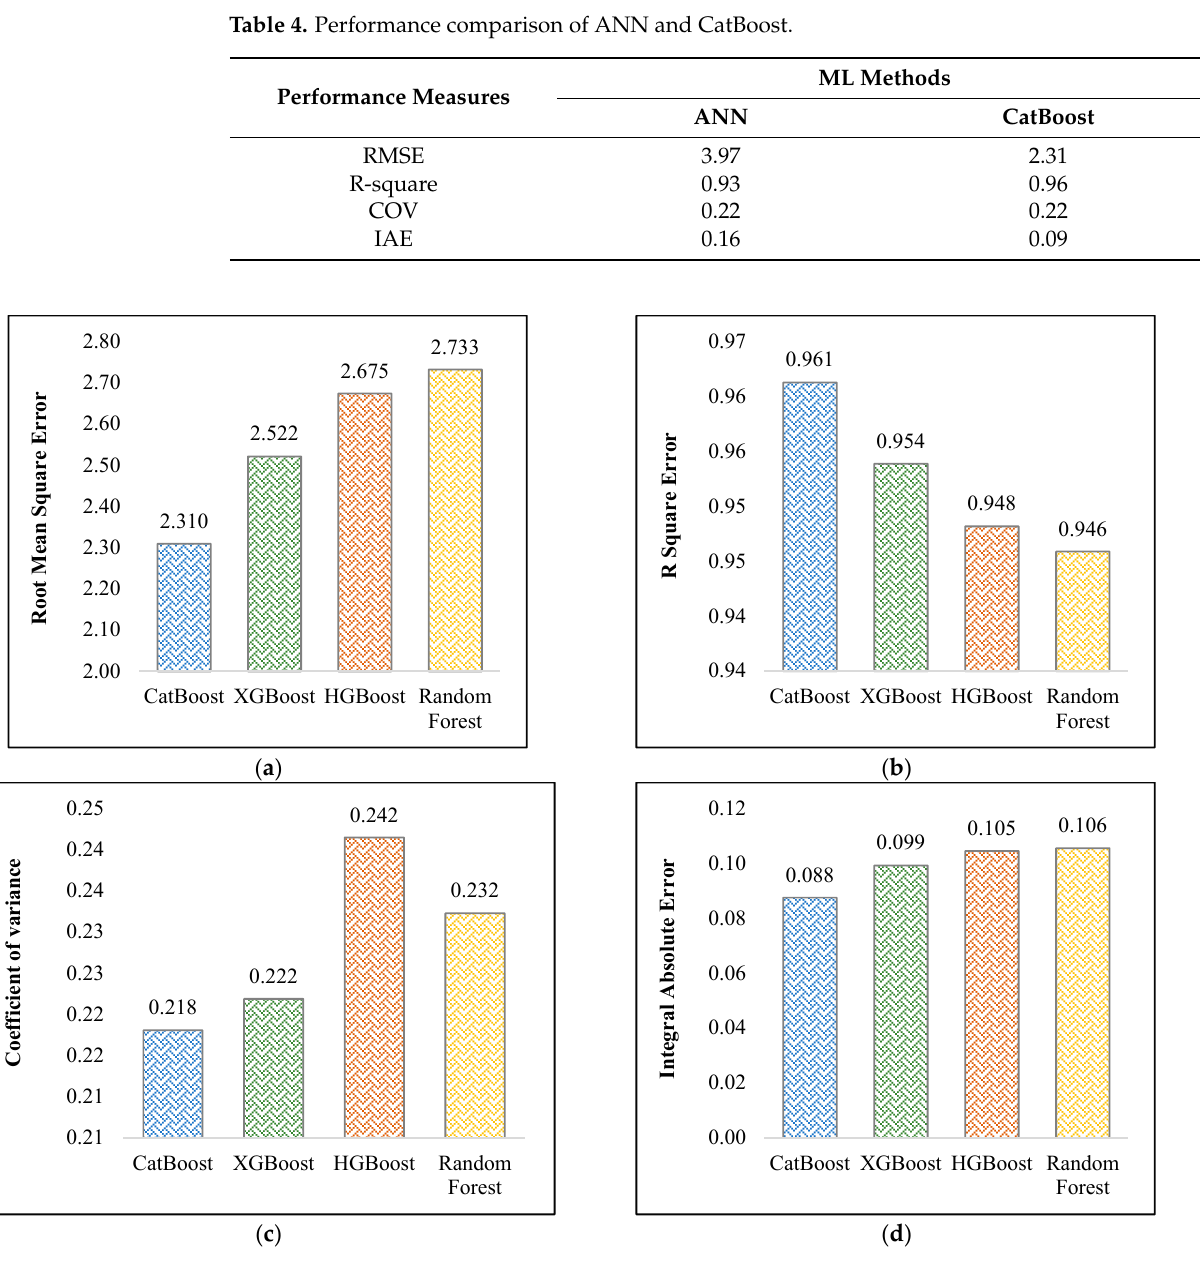
Figure 3. Performance of the ensemble methods: ( a ) root mean square error (RMSE), ( b ) R-square error (R-square), ( c ) coefficient of variance (COV), and ( d ) integral absolute error (IAE).